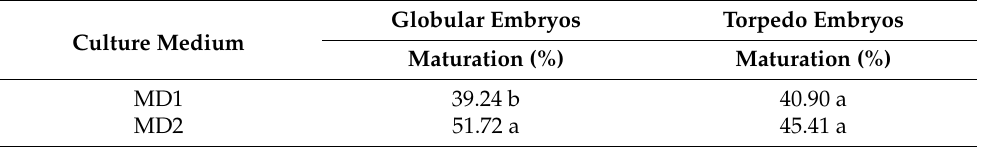
Table 4. Percentage of globular and torpedo embryos of Coffea arabica var. Colombia that reached maturity (cotyledonary stage) after 30 days of culture on the maturation